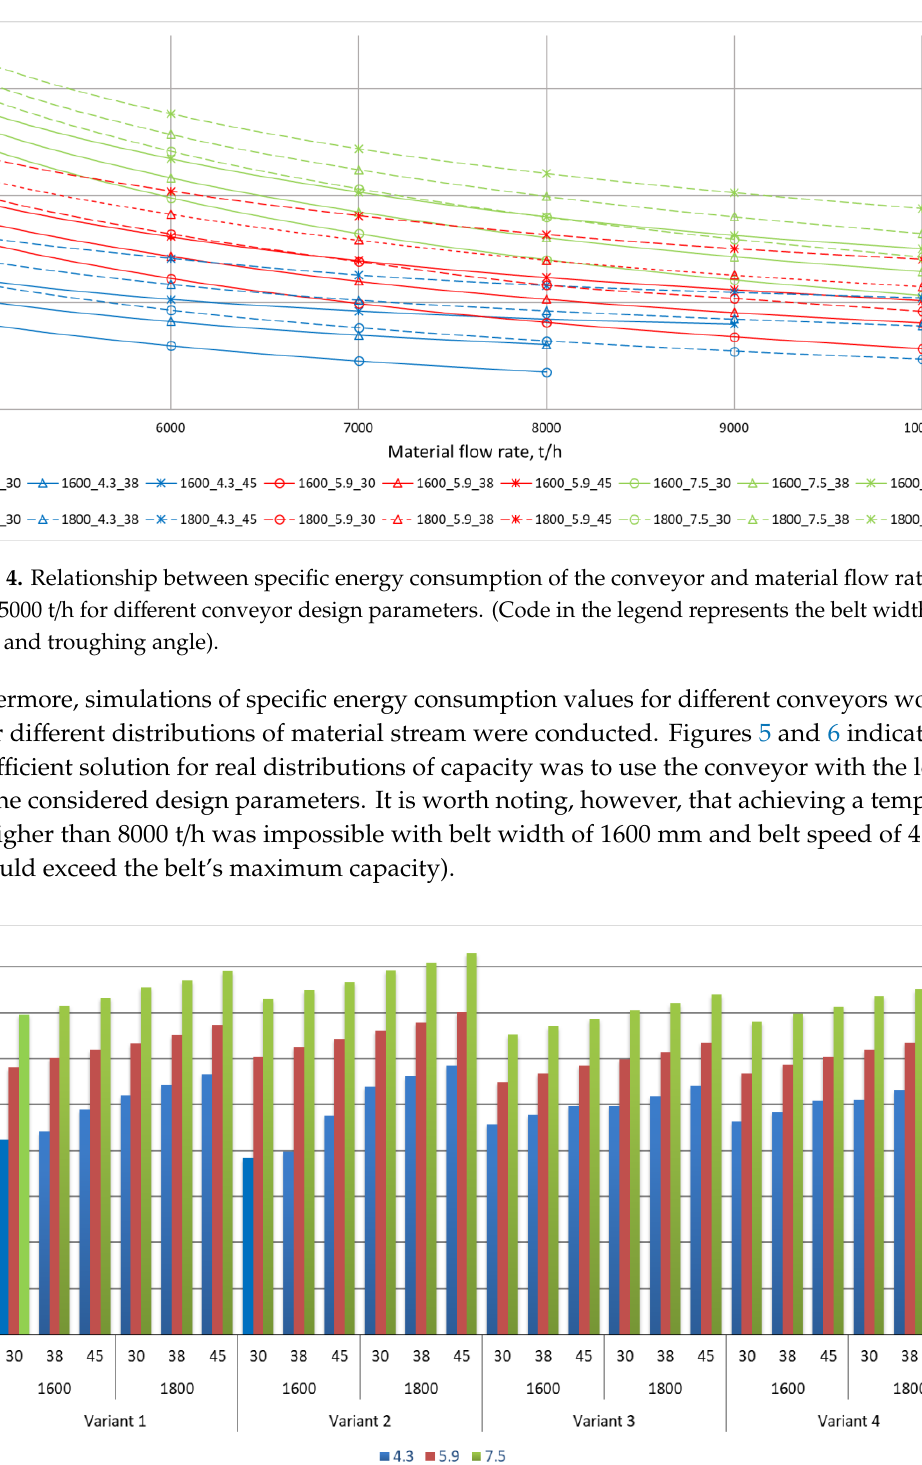
Figure 5. Bar chart of the conveyor’s specific energy consumption in belt speed series for conveyors of different design parameters working in four different variants of transported material distribution.